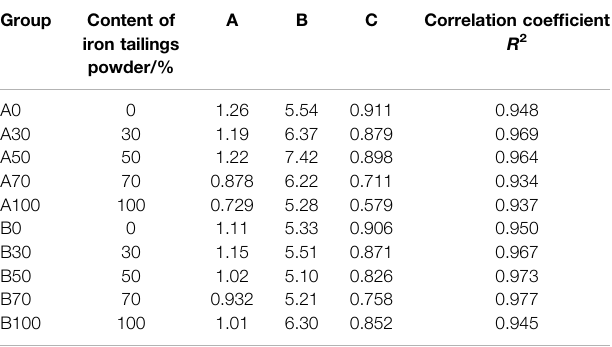
TABLE 11 | Model calculation value and the real value of concrete compressive strength